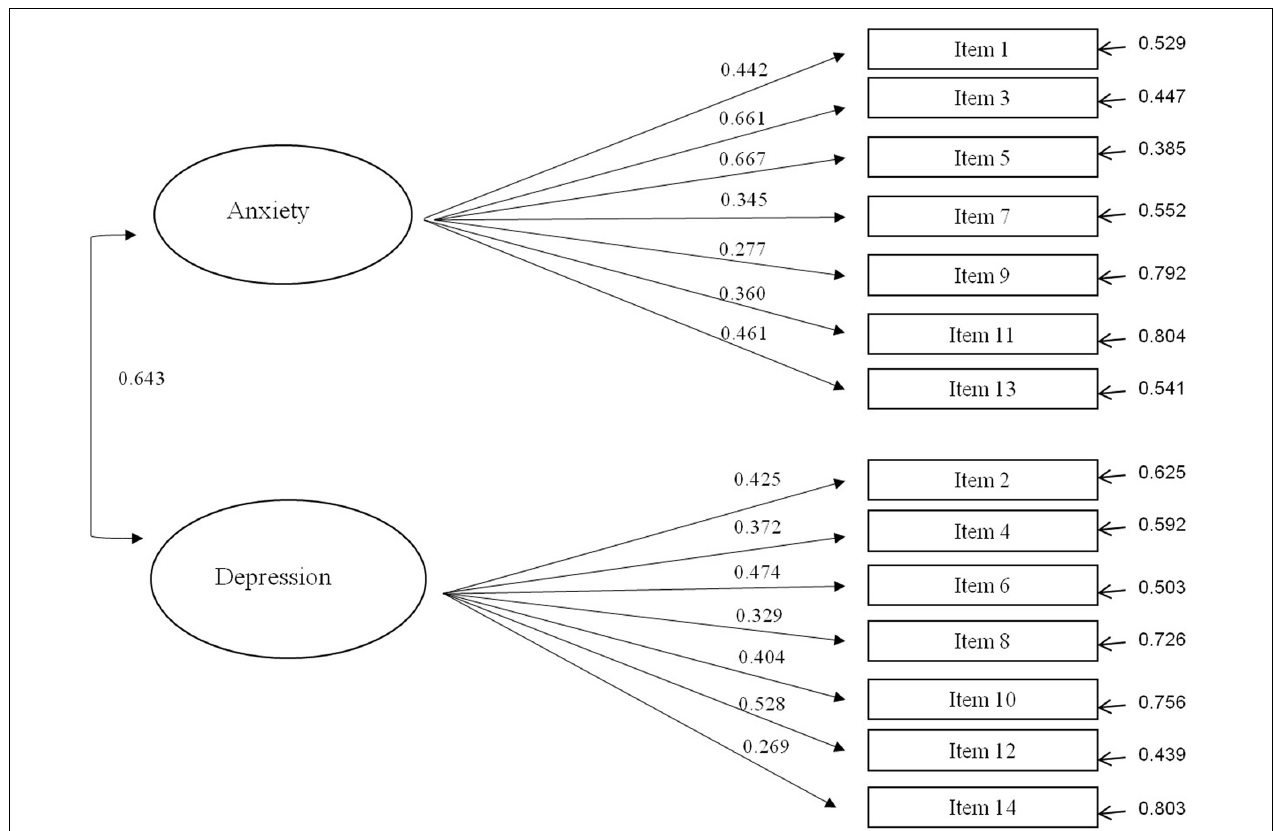
FIGURE 1 | Path diagram for the confirmatory factor analysis of HADS with standardized regression